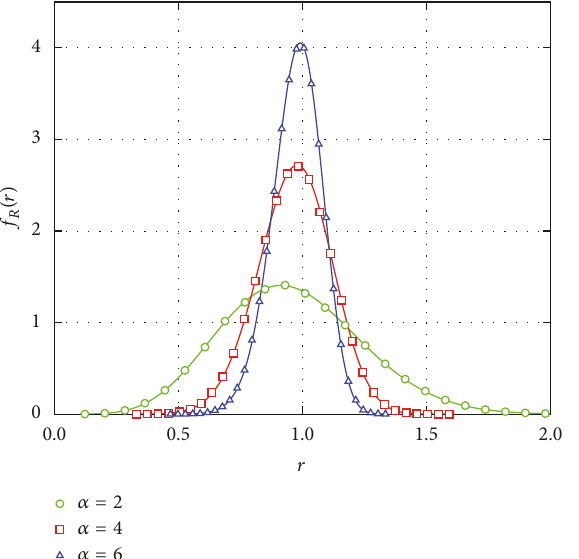
Figure 3: Empirical and theoretical 𝑓 𝑋 (𝑥) distribution with 𝜇 = 3 .